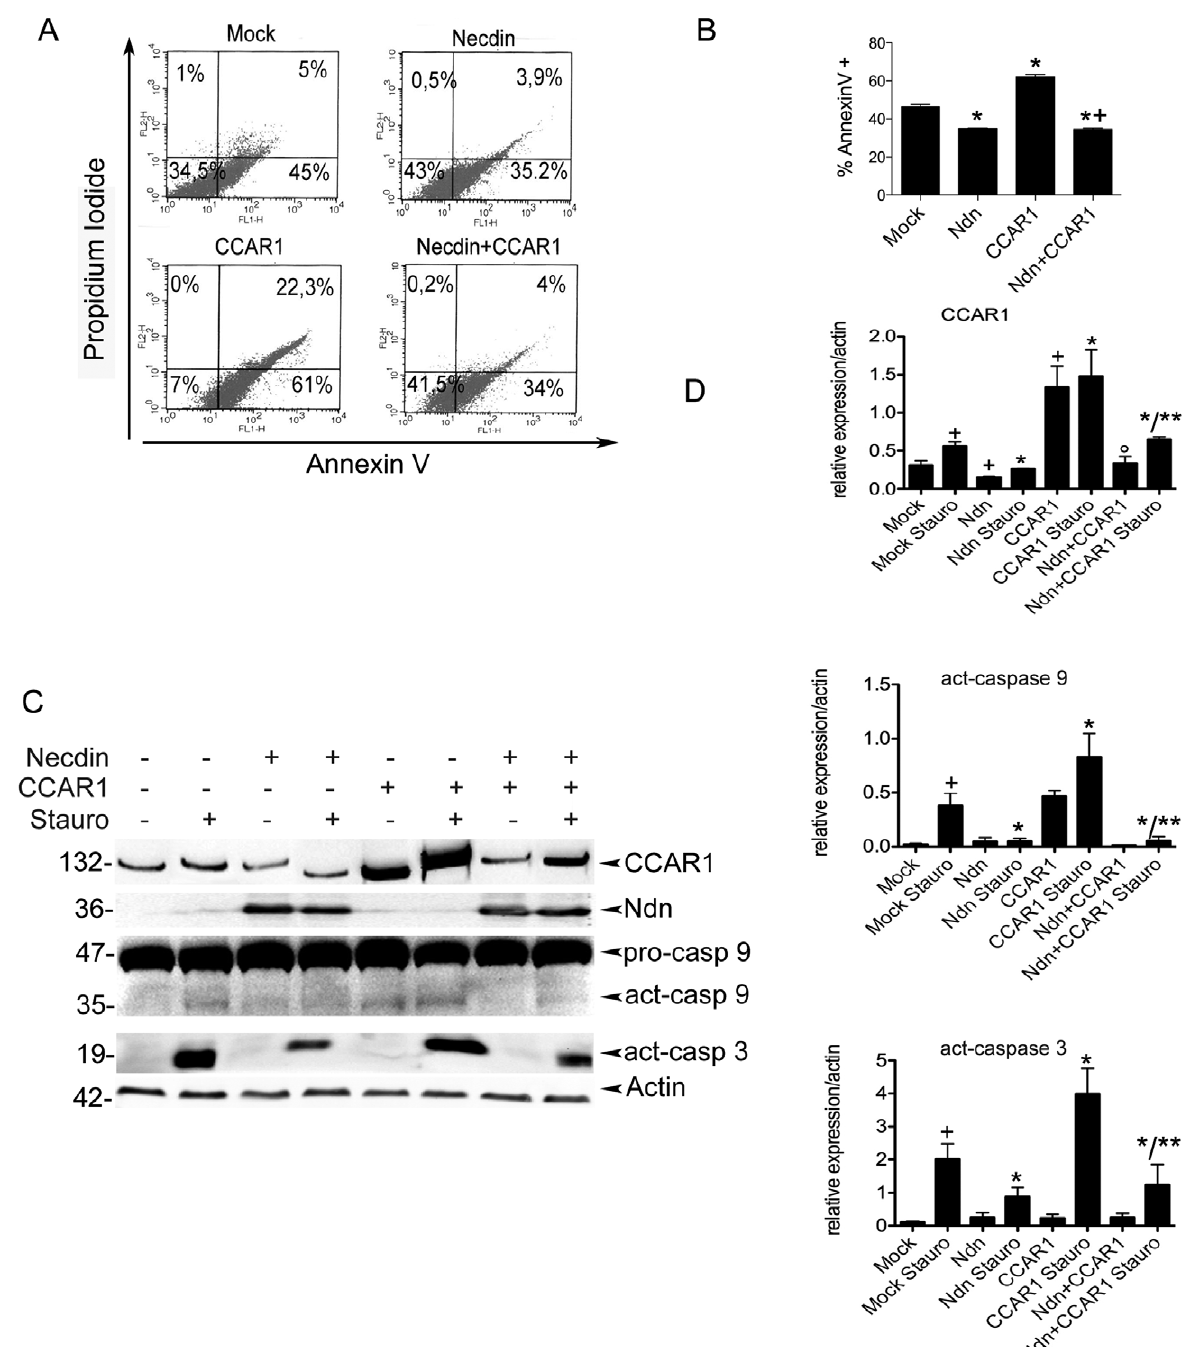
Figure 2. Necdin protects myoblasts from apoptosis by inhibiting CCAR1 activity. A) C2C12 myoblasts were transfected with pCMV-FLAG (Mock) pCMV-FLAG-Necdin (Ndn), and /or pSG5-HA-CCAR1 (CCAR1, Ndn + CCAR1). After 60 h all cells were treated with 200 nM Stausporine for 12 h and cells were collected to measure Annexin V-FITC and non vital-dye propidium iodide (PI) by flow cytometry. Dot plot analyses are representative of four similar experiments. Percentage indicates the proportion of cells that are PI and Annexin V double negative (bottom left section of the plot), PI and Annexin V double positive (top right), PI positive (top left), and Annexin V positive (bottom right). B) The graph on the right show percentage of cells positive for AnnexinV (indicating cells in early apoptosis). Data are representative of four independent experiments (* p , 0.02 respect to mock transfected cells; + p , 0.01 respect to CCAR1 transfected). C) Representative western blot showing expression of pro-caspase 9 (pro-casp 9), activated caspase 9 (act-casp 9), activated caspase 3 (act-casp 3), CCAR1, necdin (Ndn) and b -actin as loading control, on C2C12 myoblasts transfected with pCMV-FLAG-Necdin, pCMV-FLAG and/or pSG5-HA-CCAR1, treated for 3 h with 200 nM Staurosporine. D) Graphs show mean values 6 s.e.m. obtained from the ratio of densitometric values of protein/ b -actin bands on the blots in (B). Data are representative of three independent experiments. ( + p , 0.02 vs mock transfected ; * p , 0,01 vs mock transfected Staurosporine treated; u p , 0,05 vs CCAR1 transfected; ** vs CCAR1 transfected Staurosporine treated).